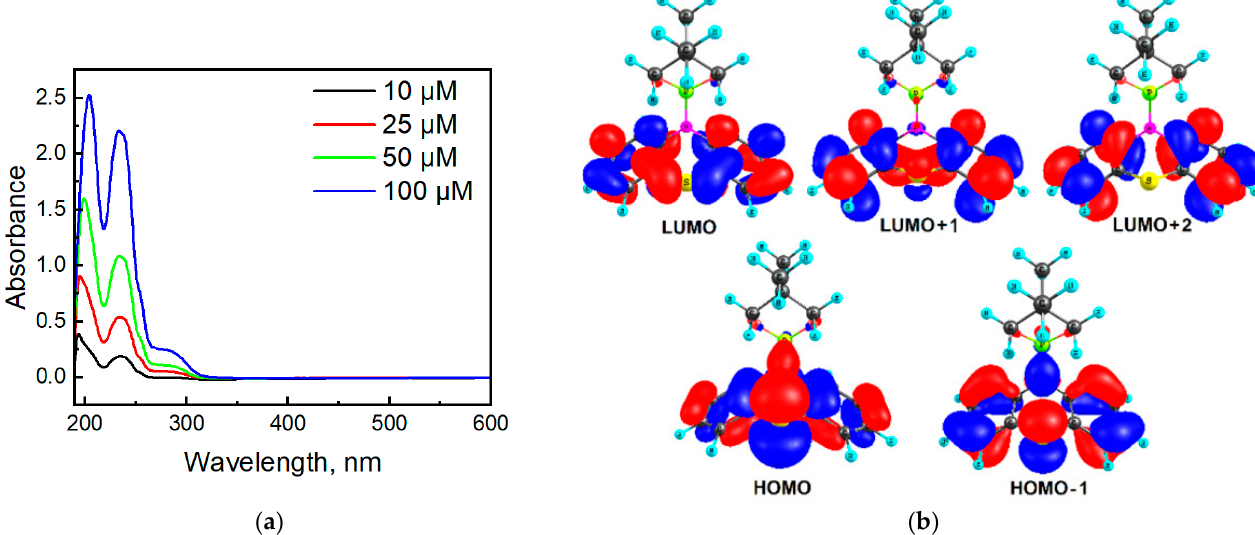
Figure 8. Absorption spectra of molecule 2a in MeCN ( a ) and orbital diagrams for compound 2a calculated at the B3LYP/6-31G(d,p) level of theory ( b ).